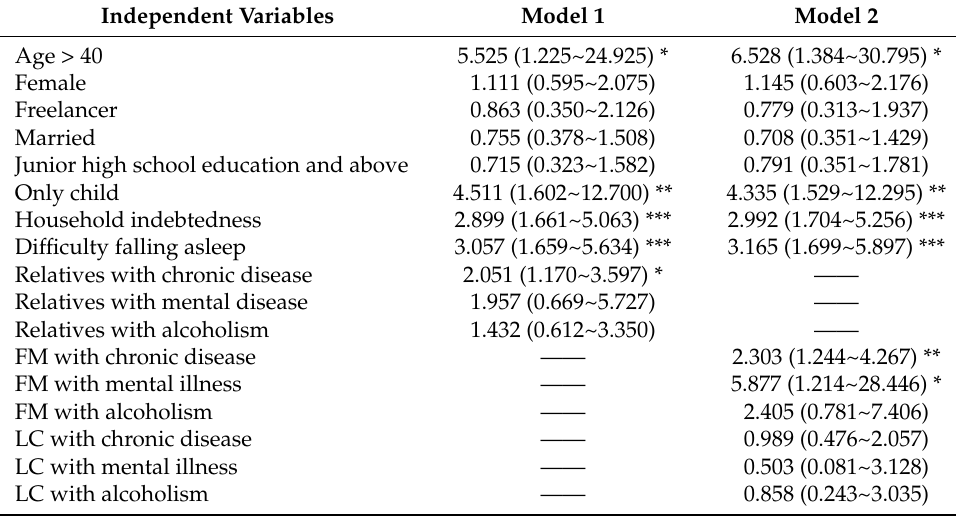
Table 2. Logistic regression analysis of risk factors associated with suicidal ideation among rural adults {OR